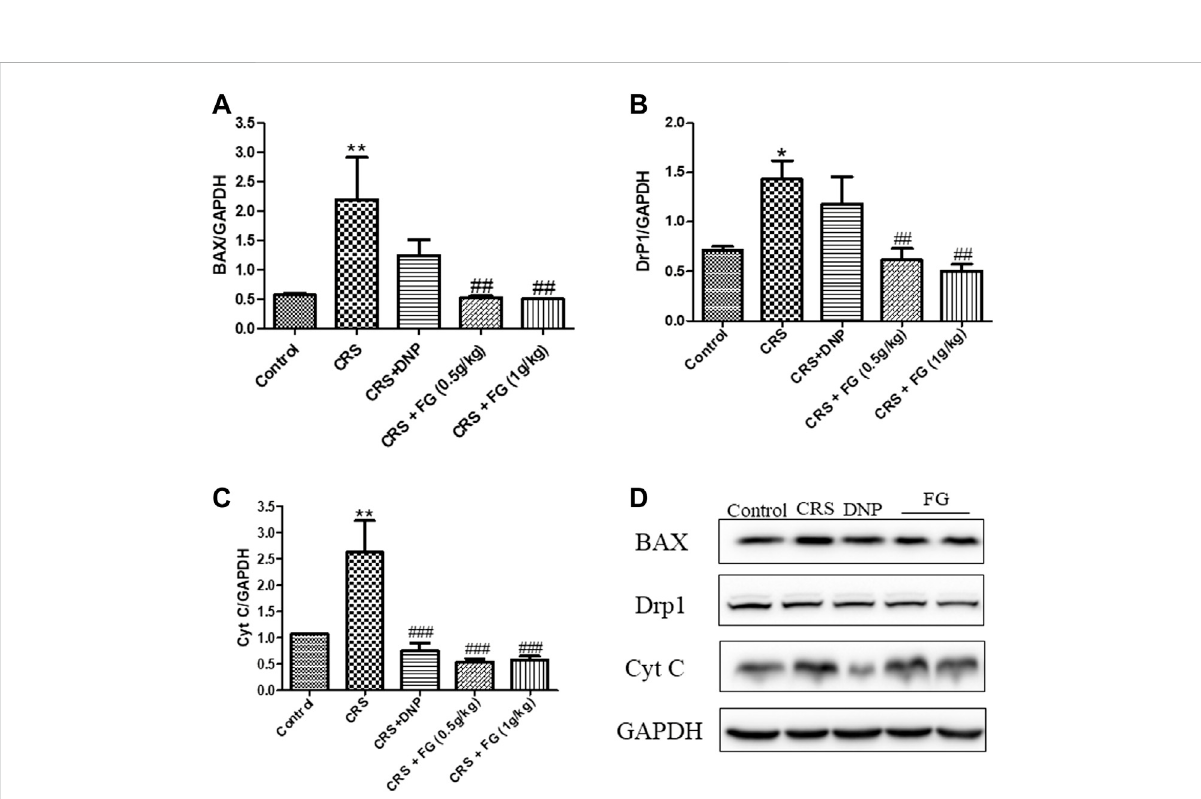
FIGURE 10 Effects of CRS, FG, and DNP on apoptosis-related proteins expressed in the hippocampus of CRS-treated mice. (A – D) Expression levels of the proteinweremeasuredbywesternblotanalysisandtheirrespectivehistogram.n=3mice/group.Valuesrepresentthemean±S.E.M.* p < 0.05,** p < 0.01 compared with the control group; ## p < 0.01, ### p < 0.001 compared with the CRS